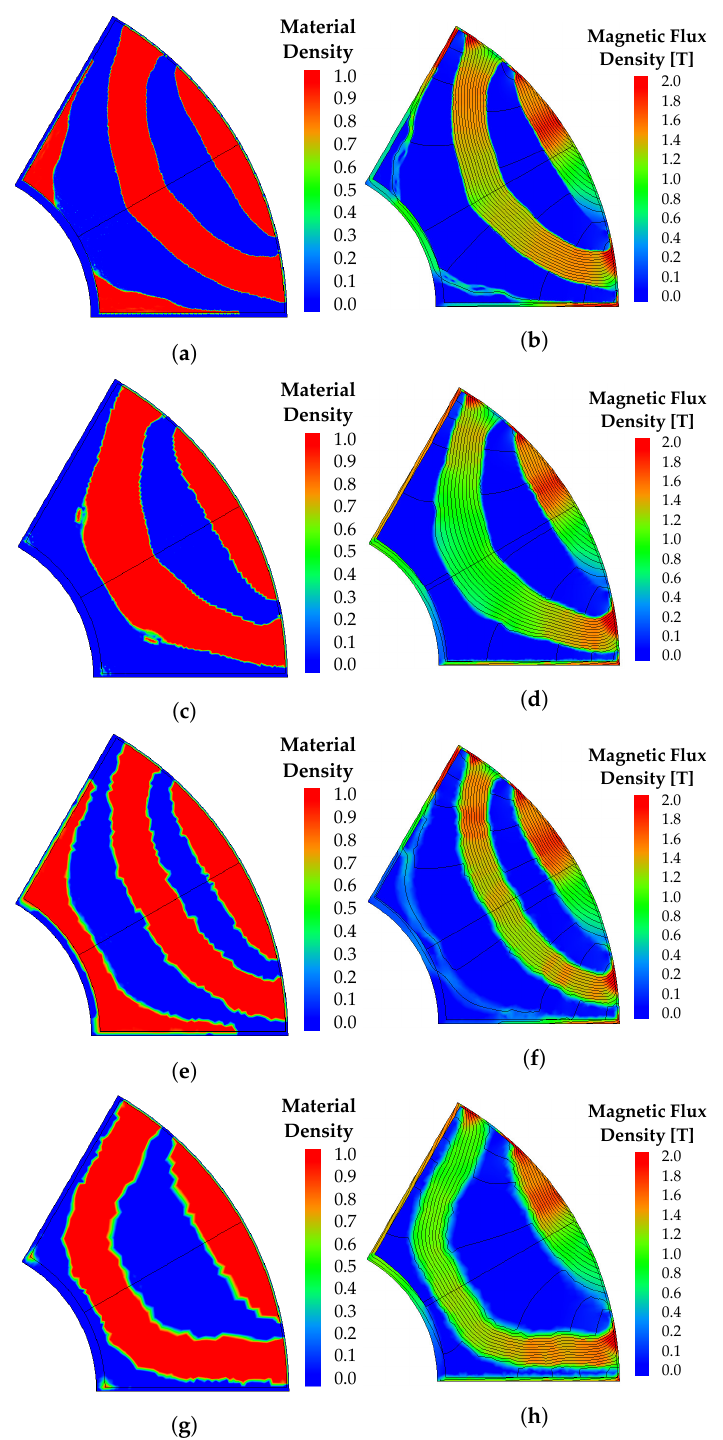
Figure 5. Density and flux density distributions for models with increasing maximum mesh lengths. ( a ) Density distribution 0.25 mm mesh; ( b ) flux density distribution 0.25 mm mesh; ( c ) density distribution 0.5 mm mesh; ( d ) flux density distribution 0.5 mm mesh; ( e ) density distribution 1 mm mesh; ( f ) flux density distribution 1 mm mesh; ( g ) density distribution 2 mm mesh; ( h ) flux density distribution 2 mm